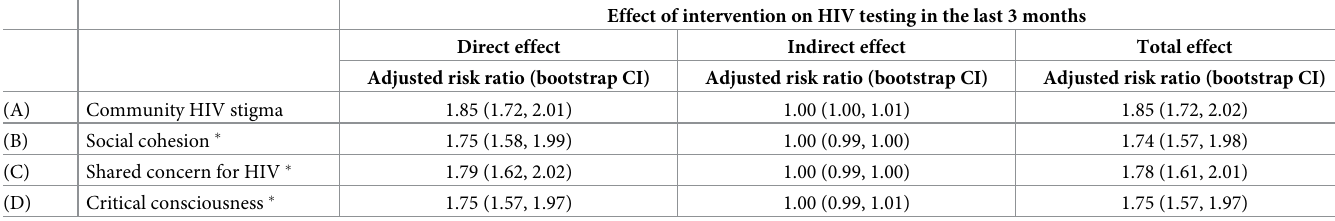
Table 3. Direct and indirect effect of community-led HIV self-testing